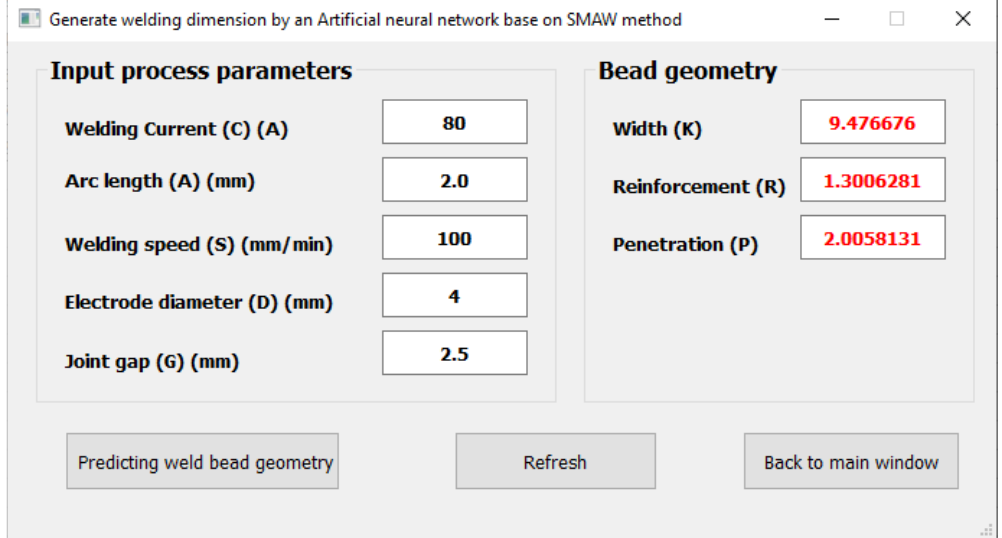
Figure 12. Screenshot of the SMAW welding module of the developed predictive system.